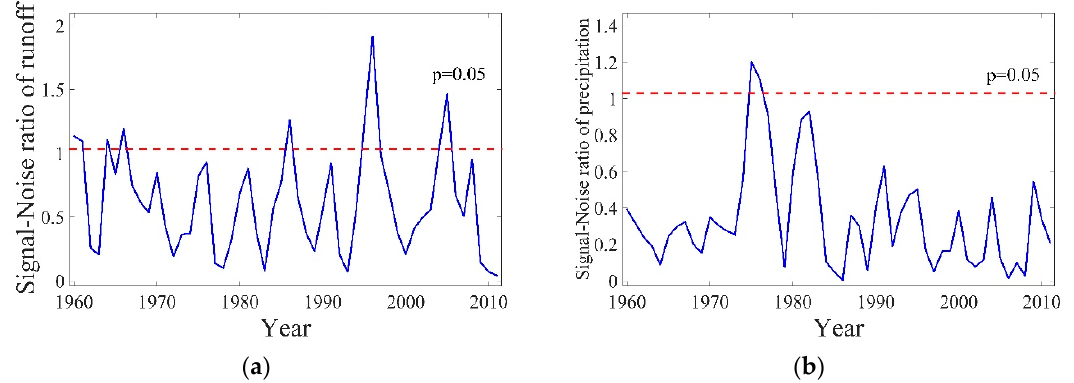
Figure 7. Mutation analysis using Yamamoto’s method: ( a ) Lhasa station runoff and ( b ) dry season precipitation. Horizontal red lines are ±95% confidence intervals.